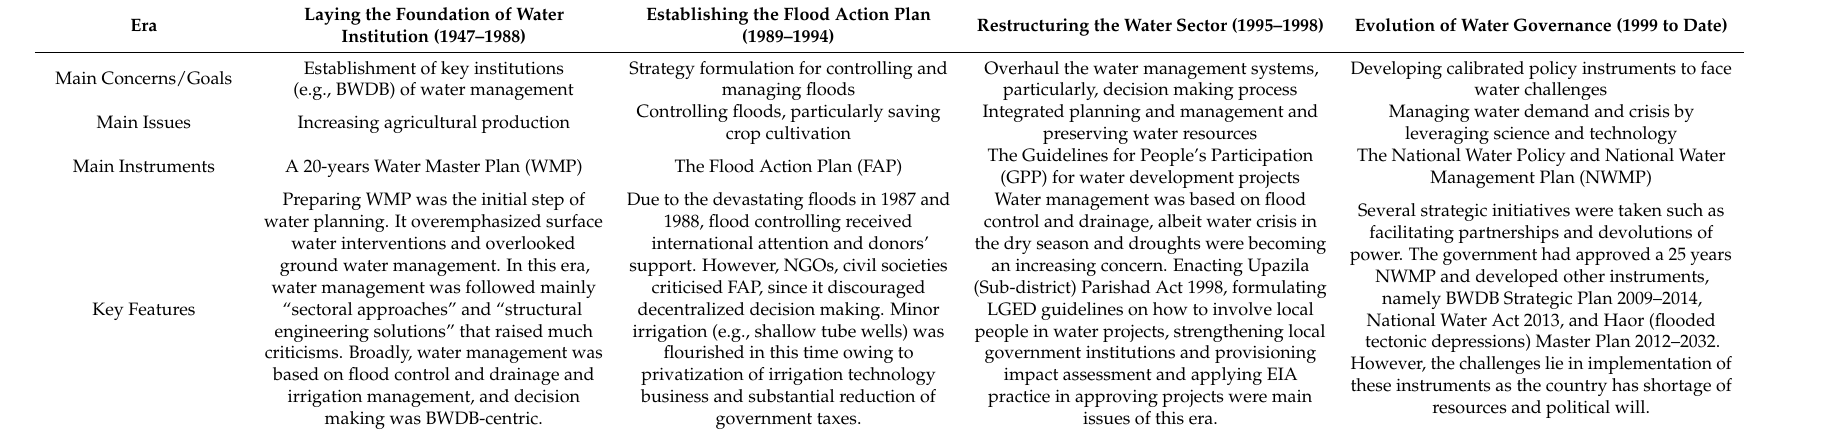
Table 1. Four eras of evolution of water policies in Bangladesh, Source: